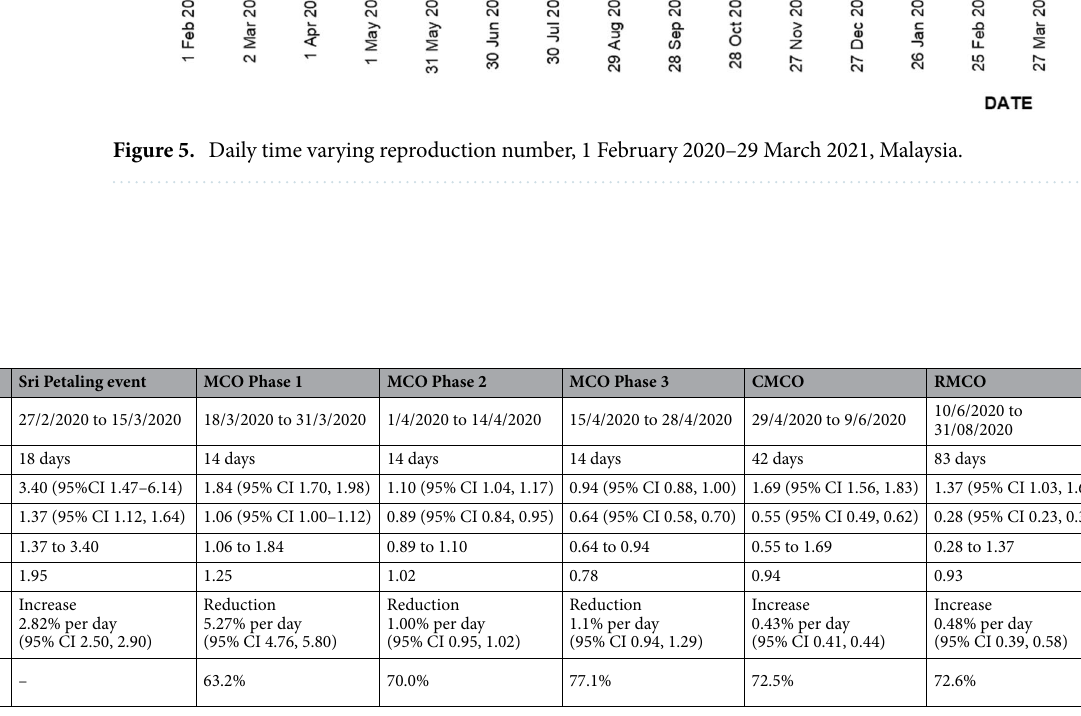
Table 2. Estimated Rt values across various events during the second wave of COVID-19. * Highest estimated Rt during the second wave of COVID-19 was 3.4 due to Sri Petaling